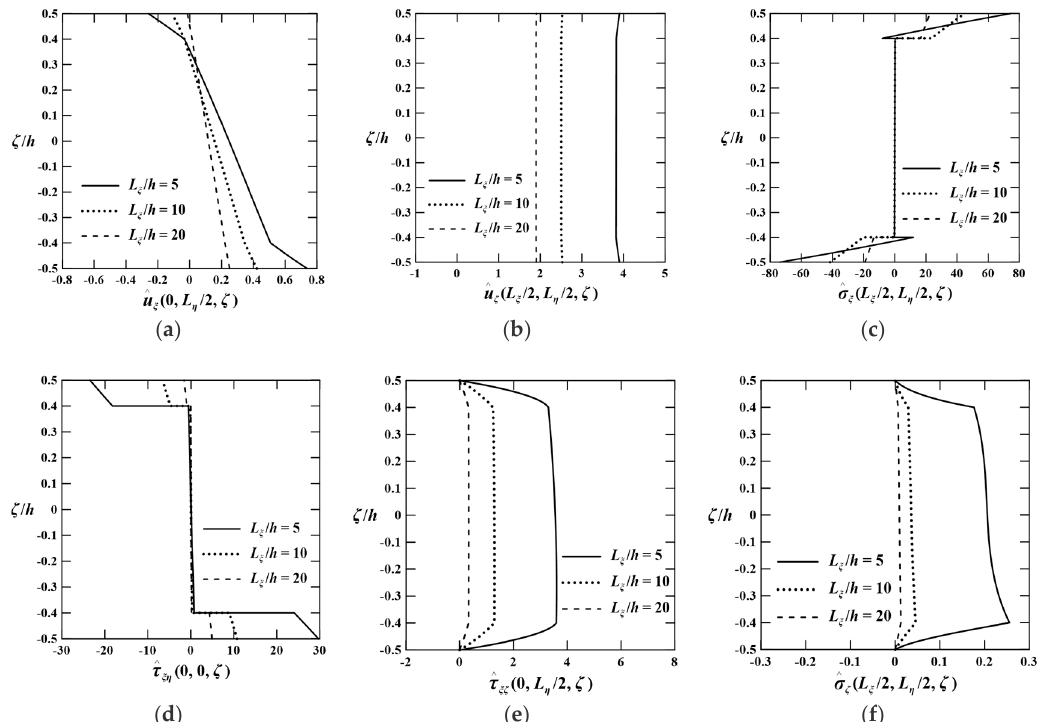
Figure 3. Through-thickness distributions of thermal and elastic field variables induced in a [0 ◦ / core / 0 ◦ ] laminated spherical shell with di ff erent values of ( L ξ / h ). ( a ) In-surface displacements; ( b ) Out-of-surface displacement; ( c ) In-surface normal stress; ( d ) In-surface shear stress; ( e ) Transverse shear stress; ( f ) Transverse normal